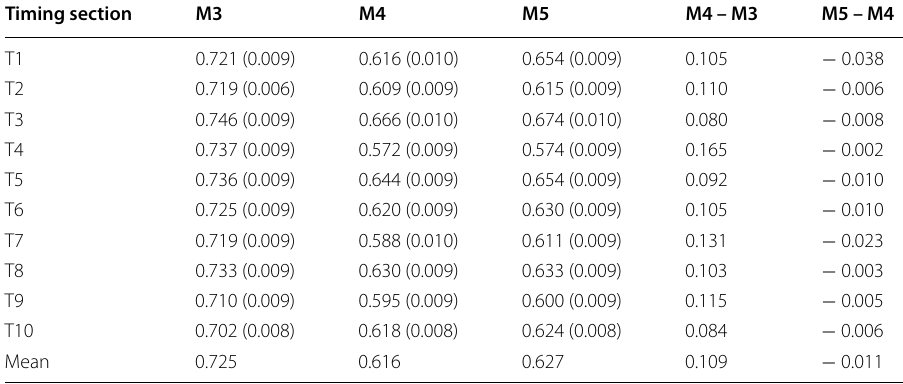
Table 2 Residual variance estimates: NAEP 2017